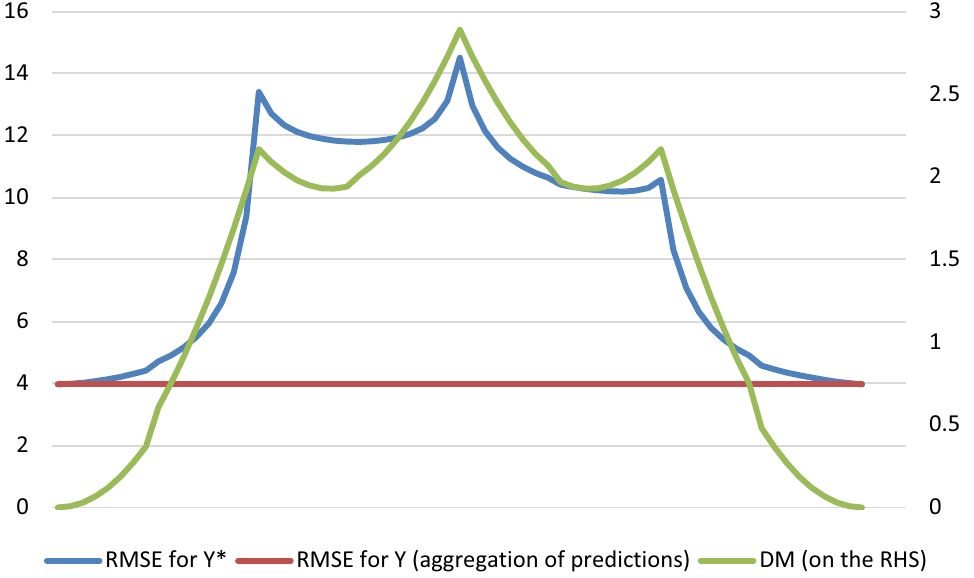
0 ) 10.000 − 1 q + 1 \ q is RMSE = (cid:31) 0 ) 10.000 − q + 1 \ q is RMSE = (cid:31)